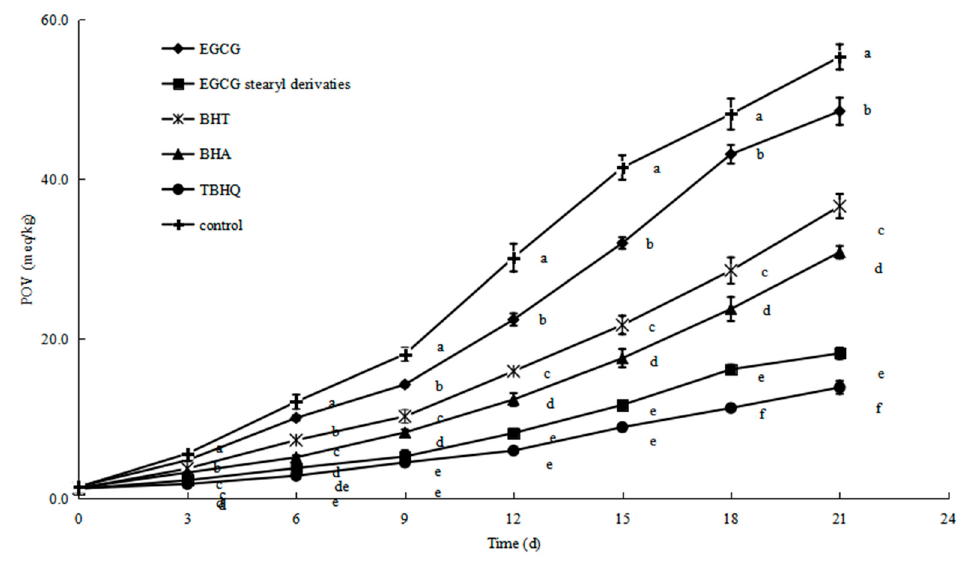
Figure 7. The POV of soybean oil containing EGCG, EGCG stearyl derivatives, and synthetic antioxidants under storage. Values followed by different letters within the same time are significantly different ( p < 0.05).